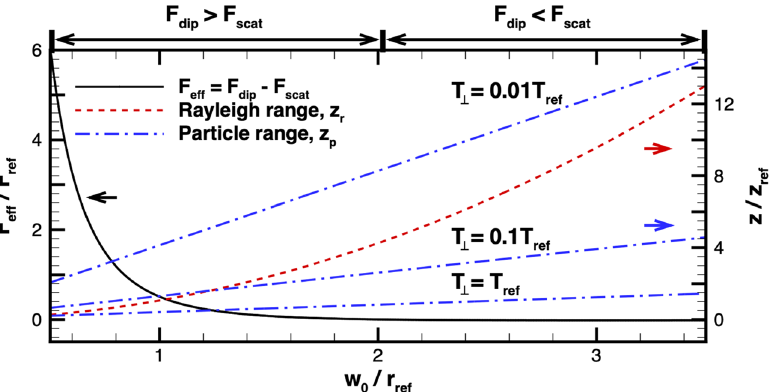
Figure 4. Relevant factors affected by the light beam waist, which is assumed to be equal to the particle beam radius. The left axis corresponds to the effective trapping force (Eq. 7) and the right axis corresponds to the light and particle characteristic lengths z r (Eq. 8) and z p (Eq. 9), respectively. Different values for the particle beam temperature are shown for z p . The light power and detuning frequency are 2.2 TW and − 19 THz, respectively. 6 24 Also note that T ref = 0.1 K, z ref = 4.68 × 10 m, r ref = 1 m, and F ref = 2.76 × 10 − N are considered for